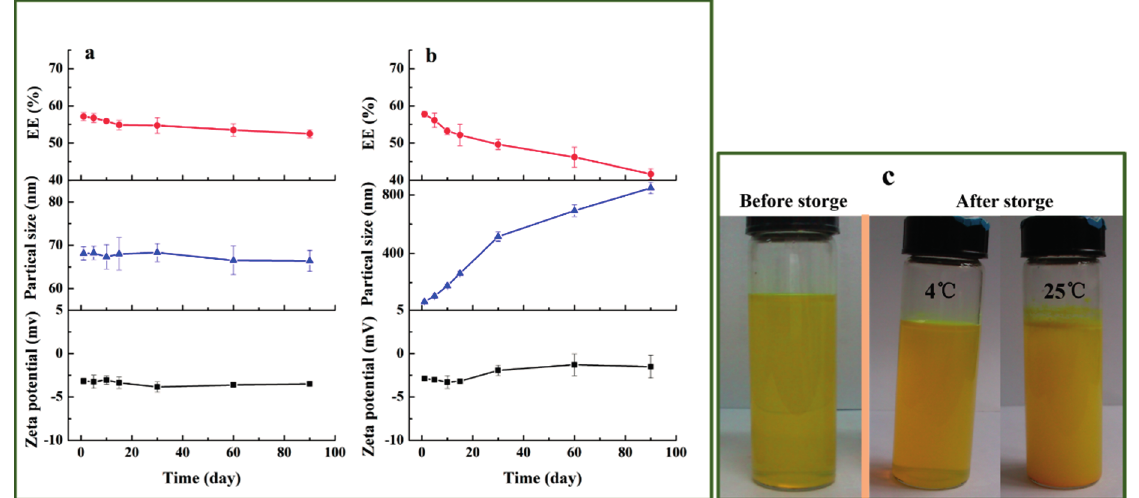
Figure 7. The changes in encapsulation efficiency, average diameter, zeta potential and